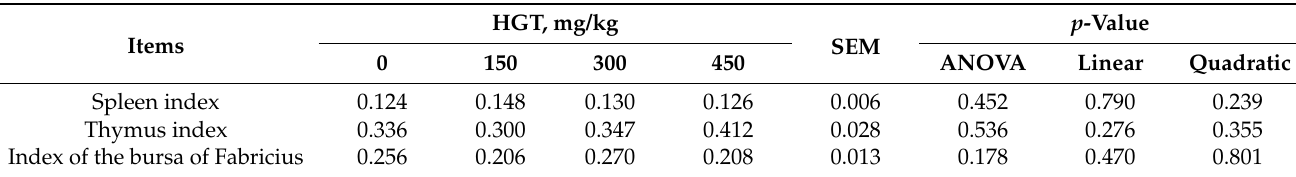
Table 4. The effects of HGT on immune organ indexes of broilers 1 .